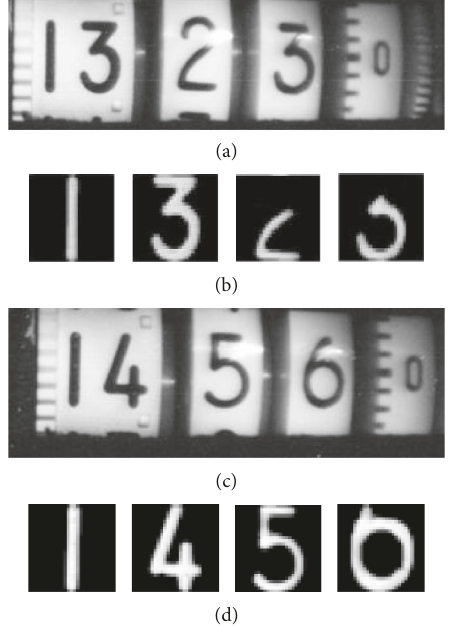
Figure 10: Original image (a, c) and segmentation result (b, d). As shown in figure (b, d), the third character and the fourth character are not completely split in (b), the fourth character is not com- pletely split in (d), resulting in incorrect recognition results.